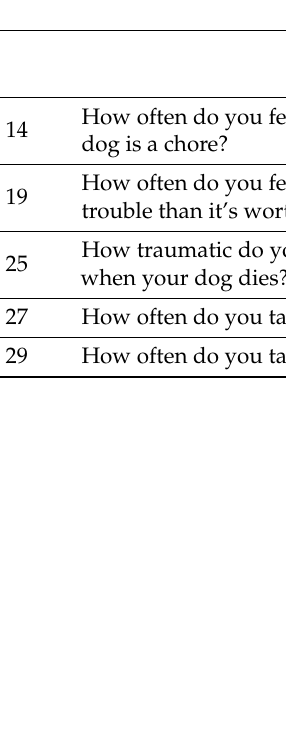
Table 4. Test–retest reliability ( n =